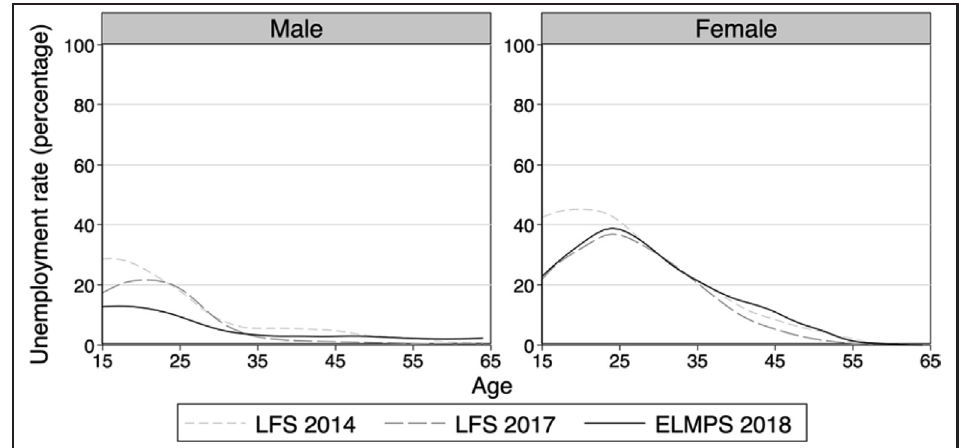
Figure 15 Unemployment rate (percentage) by sex, age, and data